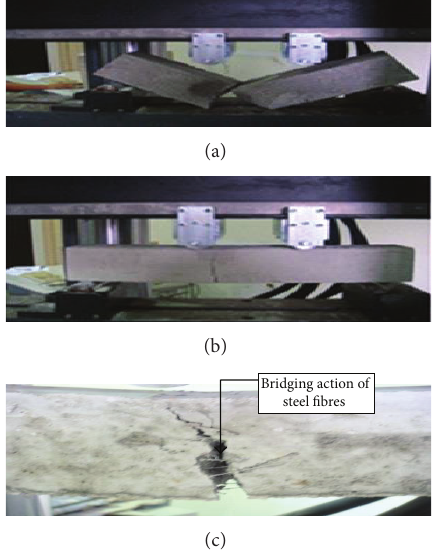
Figure 5: (a) Failure mode of NRC beam under flexural loading. (b) Failure mode of HSFRC beam under flexural loading. (c) Bridging action on steel fibers in the HSFRC